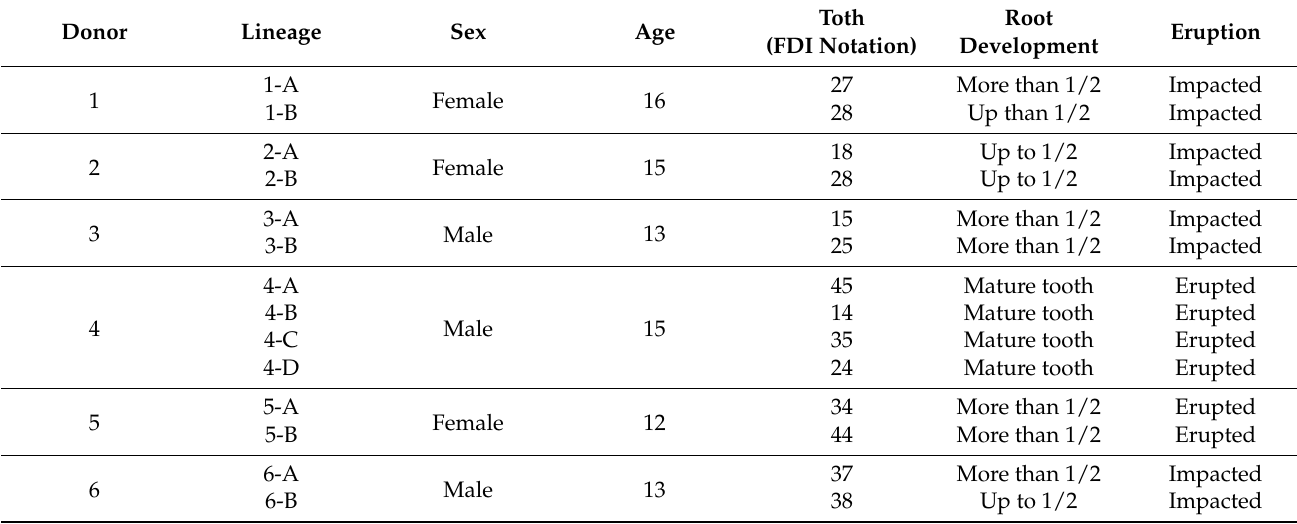
Table 1. Overview of donors’, sex, extracted teeth, and their root development, and levels of eruption.